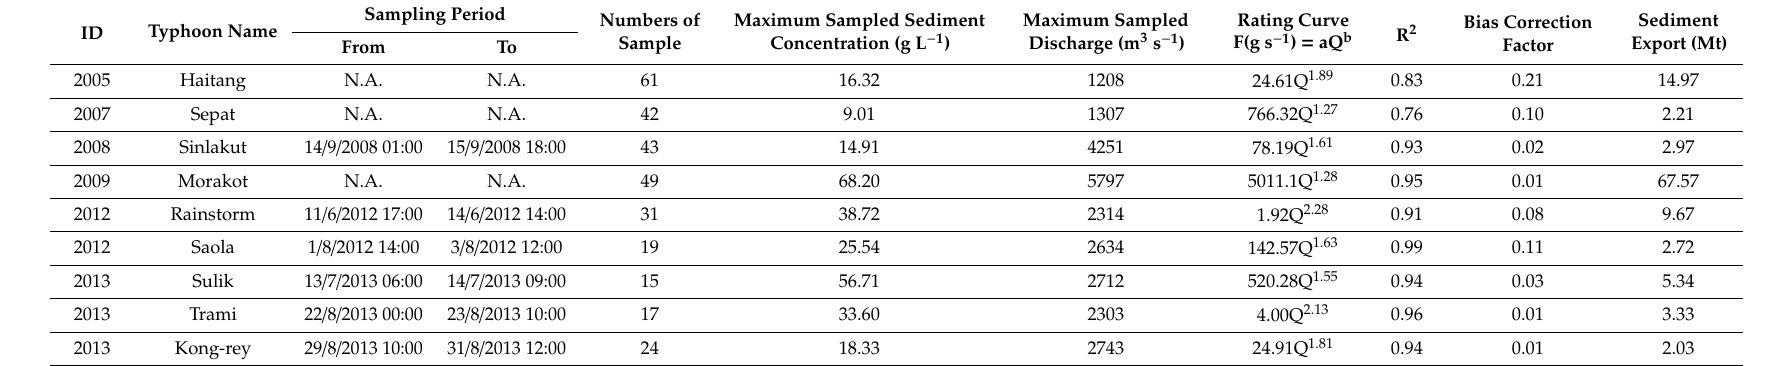
Table 2. Information for the sampled sediment data from the 9 rainfall